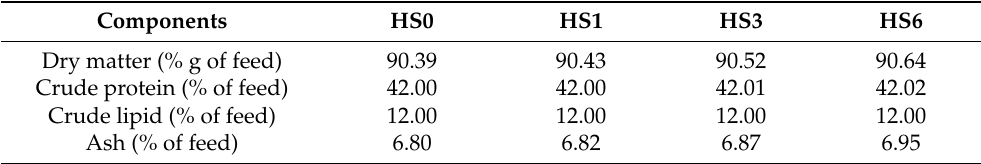
Table 2. Proximate composition (%) of experimental diets HS0, HS1, HS3 and HS6.